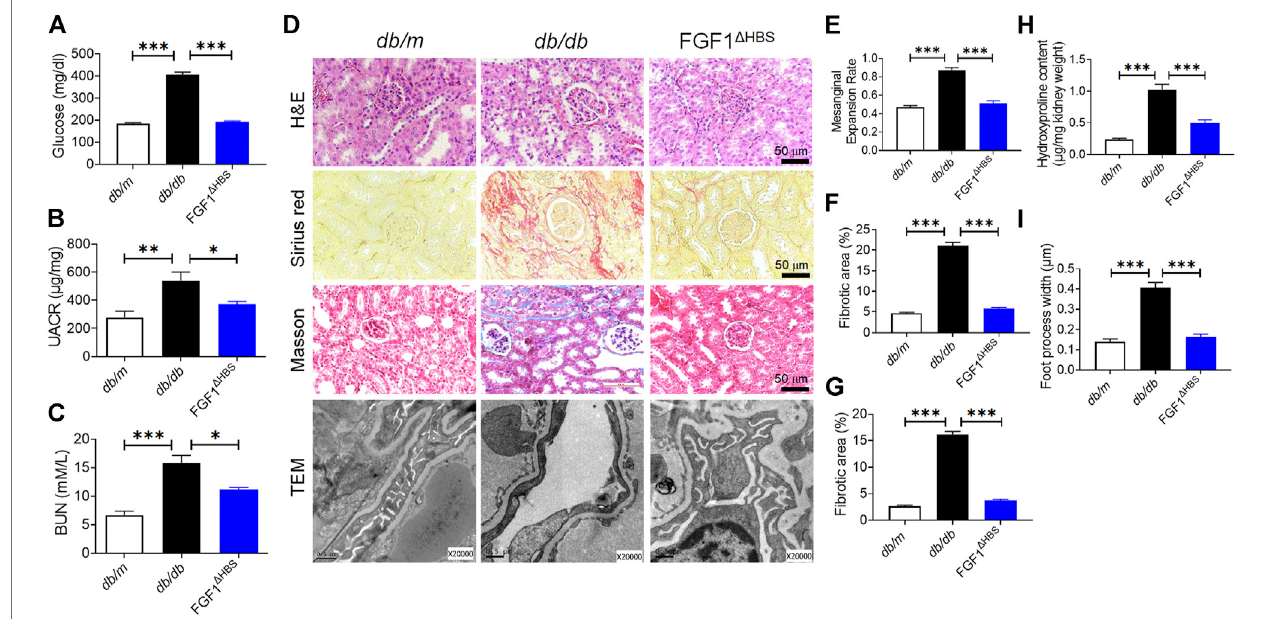
FIGURE1| FGF1 Δ HBS preventedrenalremodelinganddysfunctionind b/ d b mice. (A) Bloodglucoselevels. (B) Urinealbumin-to-creatinineratio(UACR). (C) Blood ureanitrogen(BUN)levels. (D) Representativeimagesofhematoxylinandeosin(H&E)staining,Siriusredstaining,Masson ’ strichromestainingandtransmissionelectron microscopy (TEM) images of renal tissues. (E) Quanti fi cation of mesangial expansion. (F) Quanti fi cation of the fi brotic area in Sirius red staining. (G) Quanti fi cation of the fi brotic area in Masson staining. (H) Hydroxyproline content in renal tissues. (I) Quanti fi cation of podocyte foot process effacement. Data are presented as the mean ± SEM ( n (cid:1) 6); * p < 0.05, ** p < 0.01, *** p <